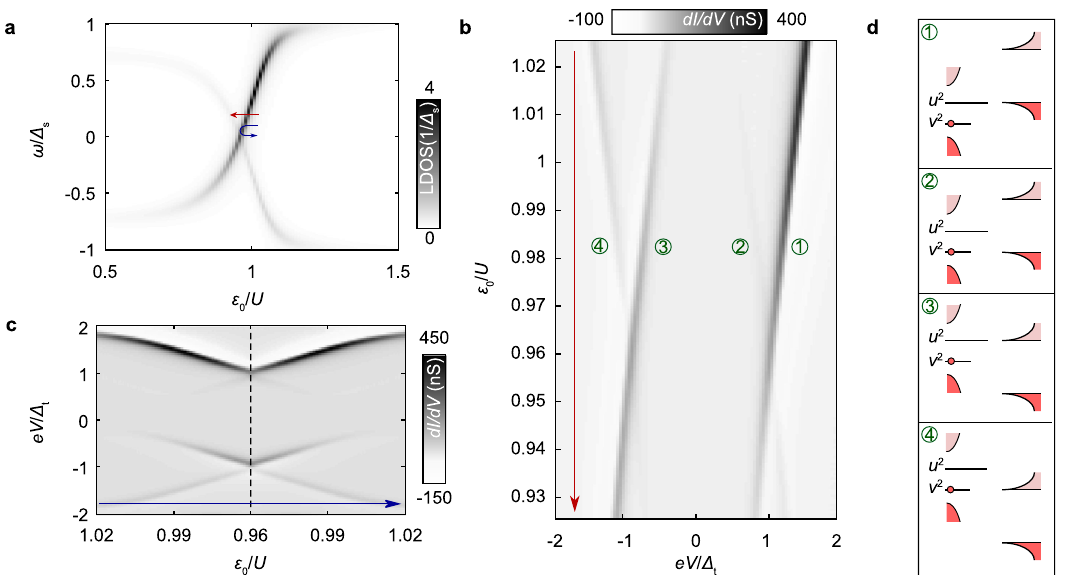
Fig. 4 Anderson impurity model for Yu-Shiba-Rusinov bound states. a Local density of states as a function of level energy ϵ 0 . The impurity spectral function was calculated within the zero-bandwidth approximation using the Lehmann spectral representation for the retarded Green ’ s function (see Supplementary Note 2). Red and blue lines indicate the two different ϵ 0 sweeps plotted in b and c , respectively. b , c Relaxation dominated tunneling conductance calculated to leading order in the tip-impurity tunneling rate Γ t . Labels in b refer to processes in d . The dashed line in c shows the turning point of the blue line in a . d Guide to the eye for different conductance contributions in b and c . Processes 2 – 3 require a fi nite population of the excited state, in this case supplied by temperature. For all panels we use U = 20, Γ s = 3, Γ t = 0.04, γ = Γ r = 0.035 and k B T = 0.2, all in units of Δ s